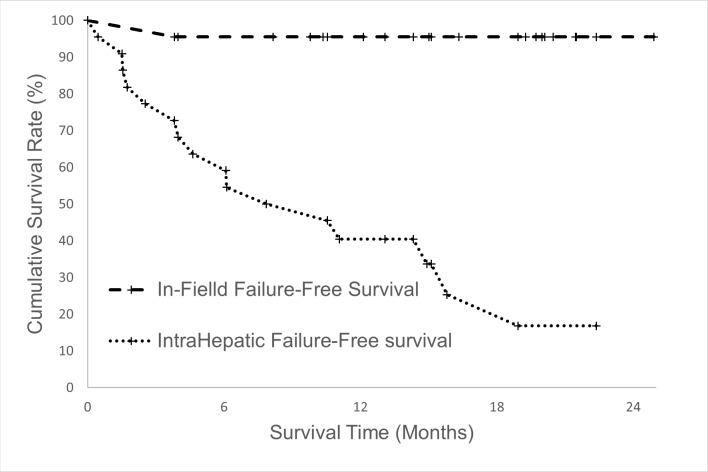
In-field failure-free survival and intrahepatic failure-free survival.The in-field failure-free survival (dotted line) and intrahepatic failure-free survival (dashed line) rate of HCC patients with NLV < 800 cm3. The patient number was 22. The 1-year in-field and intrahepatic failure-free survival rates were 95.5% and 58.7%, respectively.